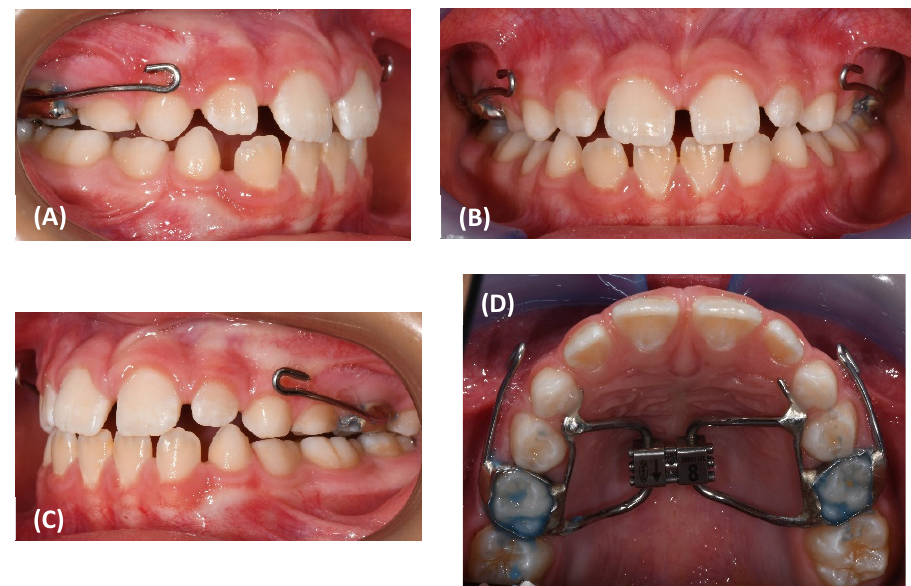
Figure 4. ( A – D ) Intraoral photograph of the Hyrax-type rapid palatal expander in place.